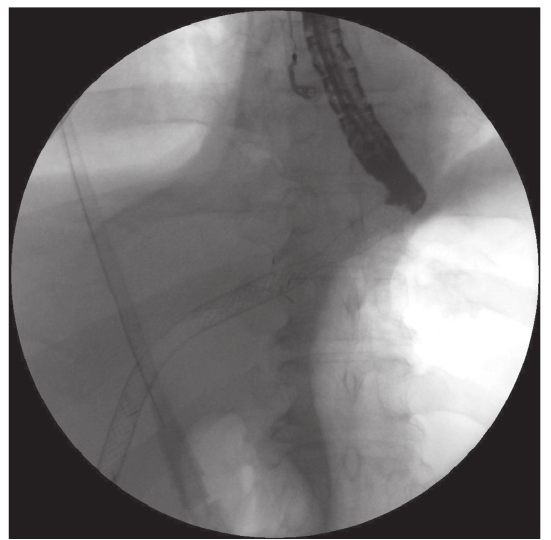
Figure 3: Endoscopic treatment of biliopleural fistula as a com- plication of endoscopic